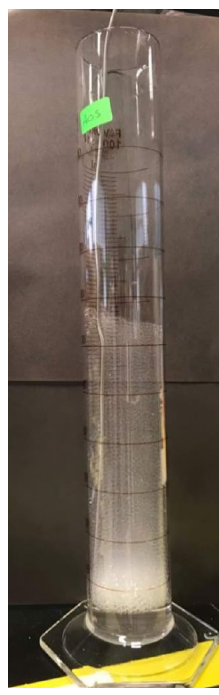
Table 3 Volumes used for making 1000 ml of 5 wt% of surfactant stock solution